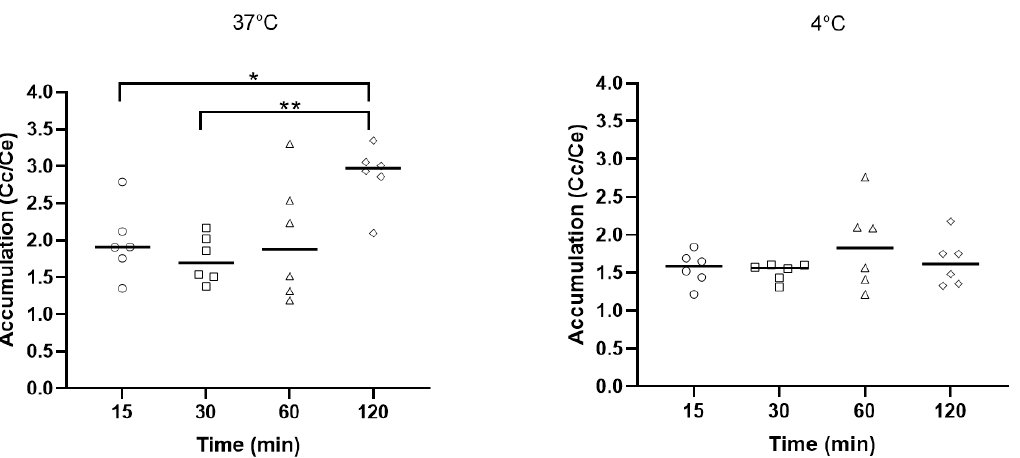
Figure 3. Accumulation factor of 3 ′ -heptyl-6-(1-pyrenyl)butyl neamine derivative at a concentration of 1.7 μ M, after 15 ( Ο ), 30 ( □ ), 60 ( ∆ ), and 120 ( ◊ ) min of incubation at 37 °C ( left ) or 4 °C ( right ) in P. aeruginosa ATCC 27583. The accumulation factor is obtained by dividing the cell concentration by the extracellular concentration. N = 2. n = 6. The statistical difference between the different times is calculated by one-way ANOVA (* p < 0.05, ** p < 0.01).